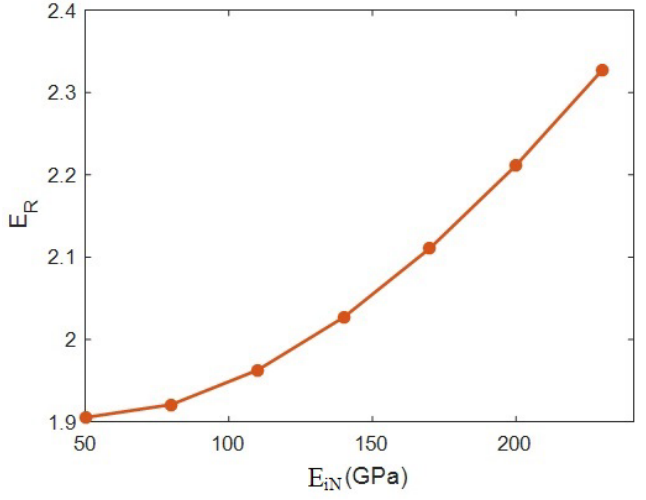
Figure 7. Outputs of Equation (17) at numerous values of interphase net modulus.